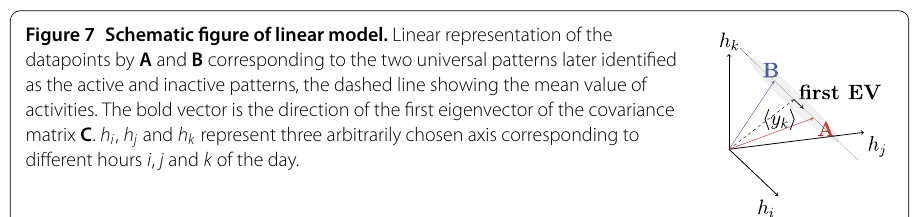
Figure 7 Schematic figure of linear model. Linear representation of the datapoints by A and B corresponding to the two universal patterns later identified as the active and inactive patterns, the dashed line showing the mean value of activities. The bold vector is the direction of the first eigenvector of the covariance matrix C . h i , h j and h k represent three arbitrarily chosen axis corresponding to different hours i , j and k of the